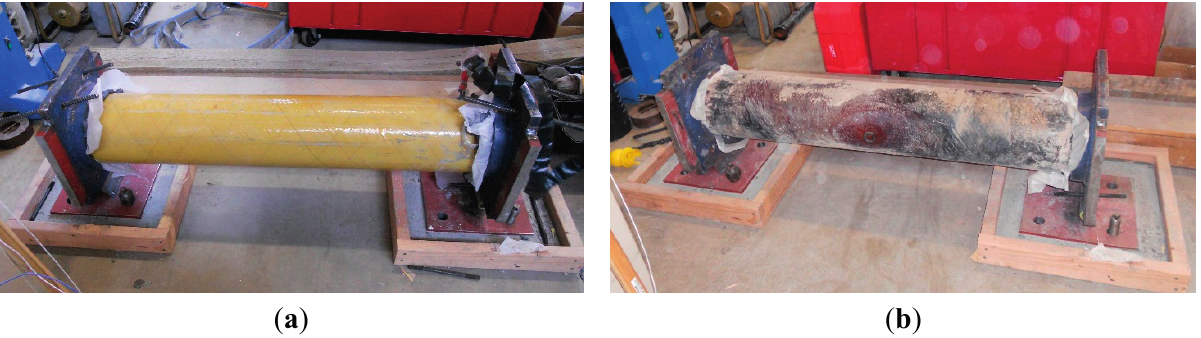
Figure 10. ( a ) Undamaged CFFT column and ( b ) discolored fire damaged CFFT